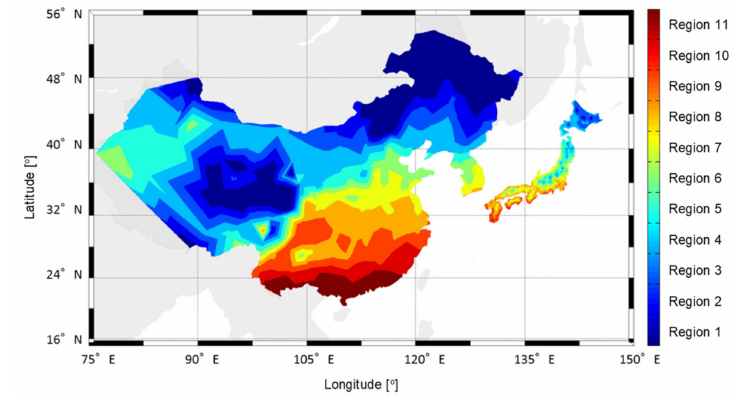
Figure 7. Classification by heating degree day (based on Table 10).